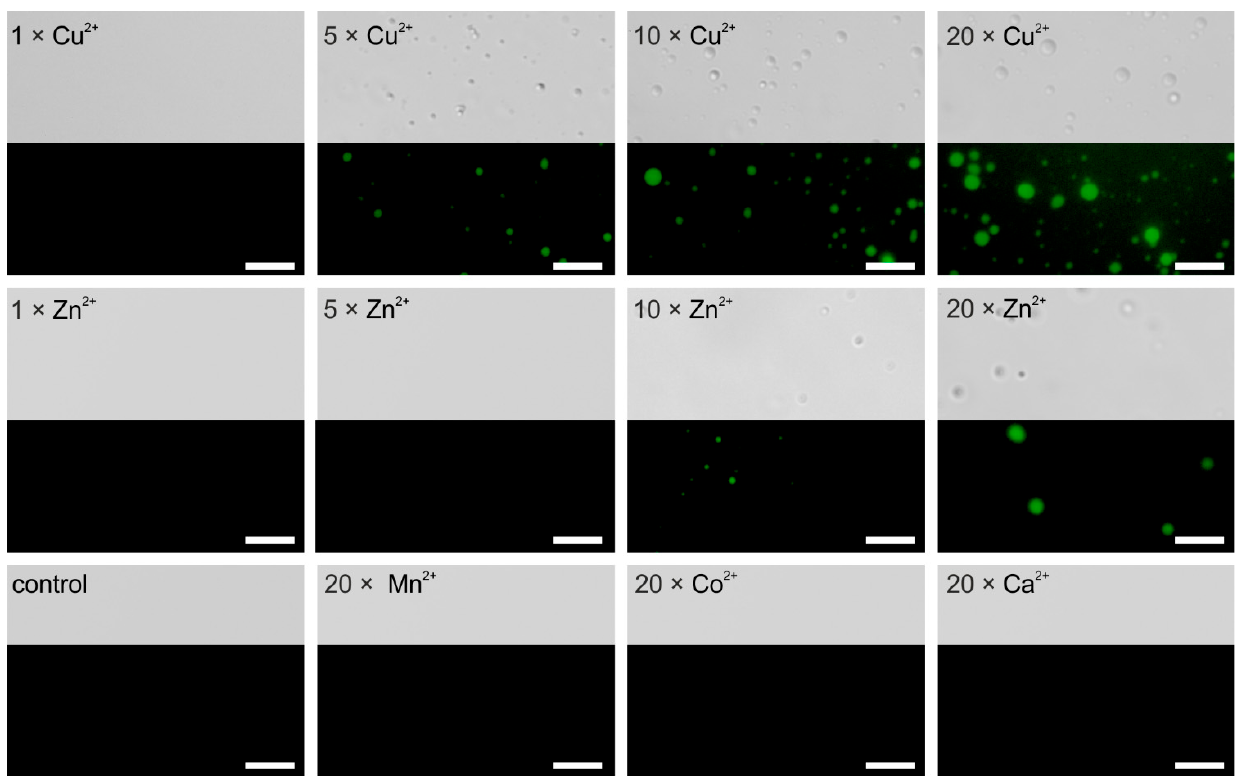
Figure 5. Metal ions-induced formation of liquid condensates by AaFEcR. The representative images of condensates observed using widefield microscopy with Differential Interference Contrast (DIC) (top) and fluorescence (bottom). The 70 µ M solution of fluorescently labelled recombinant AaFEcR in 10 mM Tris-HCl, 150 mM NaCl, and pH 7.5 buffer was analyzed. The protein solution was supplemented with various metal ions in molar excess as indicated on the image. Scale bar 5 µ